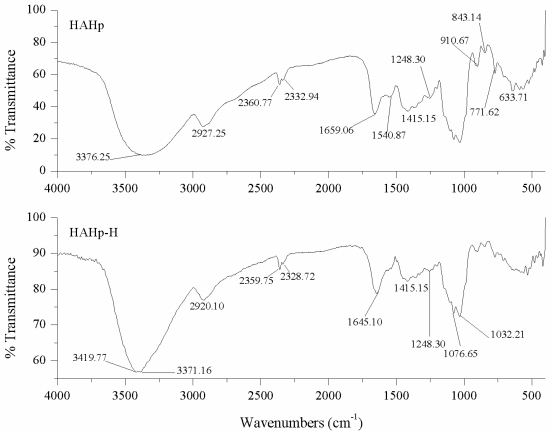
Comparison of FT-IR between HAHp and HAHp-H.